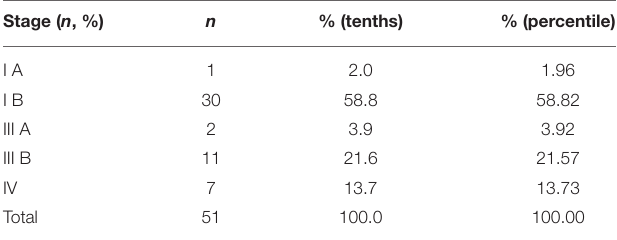
TABLE 2 | Tumor stage